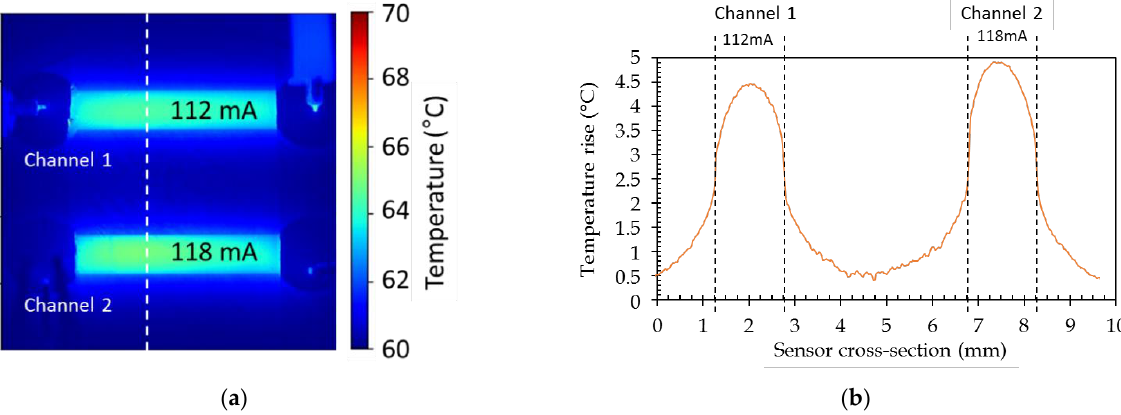
Figure 16. Control of the temperature by injecting two slightly different currents in two adjacent channels: ( a ) thermal camera measurements; ( b ) cross-sectional temperature profile (relative position).